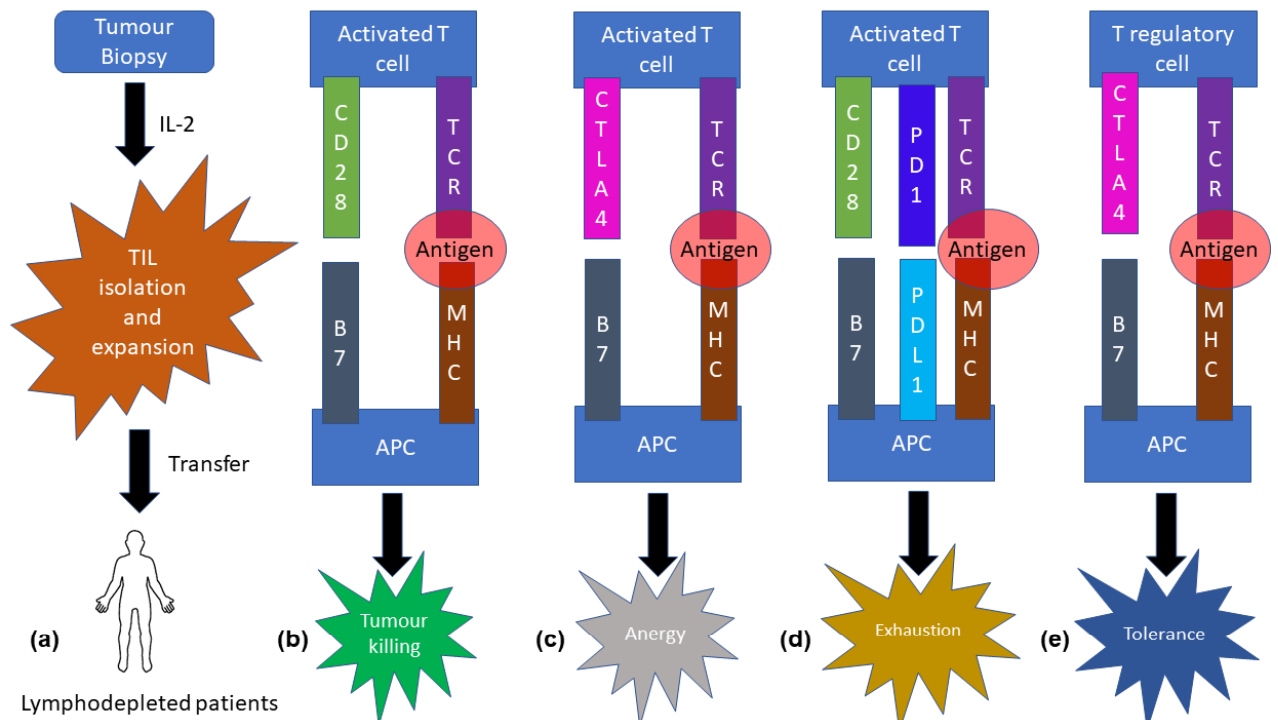
Figure 1. Simplified schematic representation of molecular biological aspect of immunotherapy. ( a ) Mechanistic approach of adoptive T-cell transfer. Tumour-infiltrated lymphocytes are isolated and expanded with the help of IL-2, then transfused to lymphodepleted patients. ( b ) Antigens bound to MHC present in APC interact with TCR, and CD28 binds with the B7 receptor, leading to the release of perforin and granzyme (not shown in the figure), resulting in tumour death. ( c ) CTLA4 competitively binds with the B7 receptor in APC, causing T-cell anergy. ( d ) PD1 and PD-L1 binding cause T-cell exhaustion. ( e ) T regulatory cells also harbour CTLA4, which binds with B7 receptors of APC, causing T-cell tolerance. Thus, the inhibition of checkpoint receptors can reverse immunosuppression.